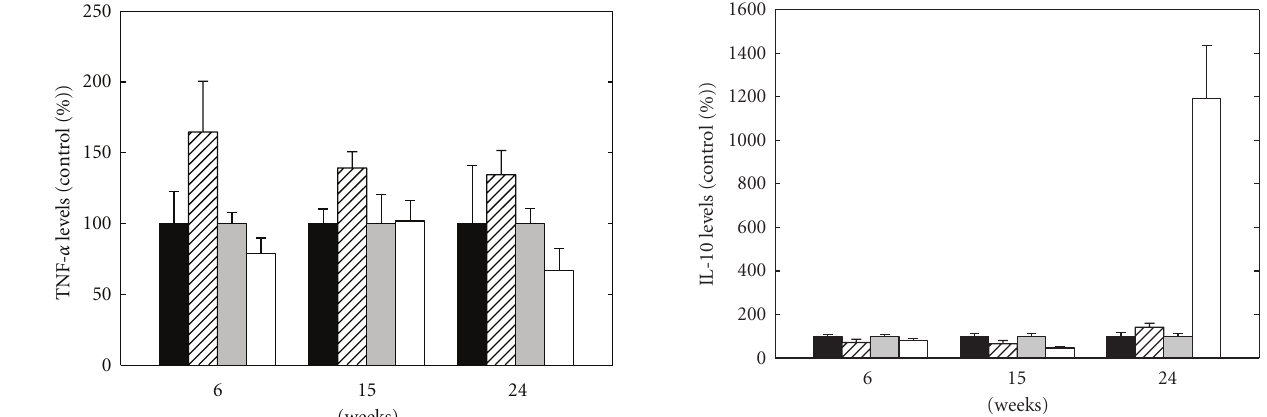
Figure 2: Secreted TNF- α levels of adjuvant mice (black bars) and eAPS mice (upward diagonal bars) versus cytosolic TNF- α levels of adjuvant mice (grey bars) and eAPS mice (white bars). The average of TNF- α level of the adjuvant control group was defined as 100%, and the results expressed as percentage of control group at the same time point. Results are presented as the mean ± SEM.